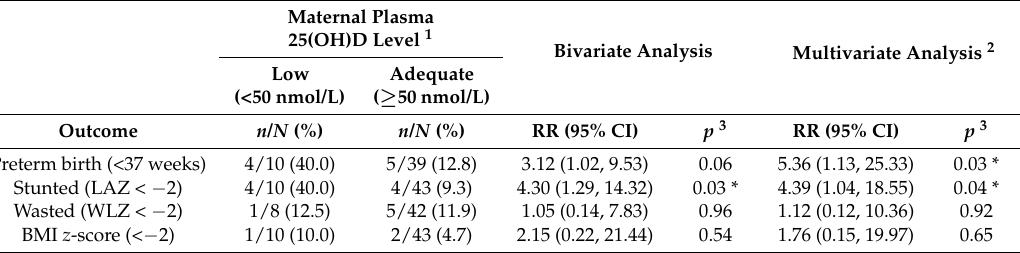
Table 3. Low Maternal Vitamin D at Enrollment and Adverse Pregnancy